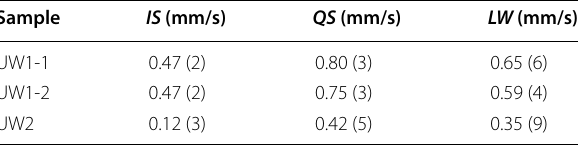
IS isomer shift; QS quadrupole splitting; LW line width